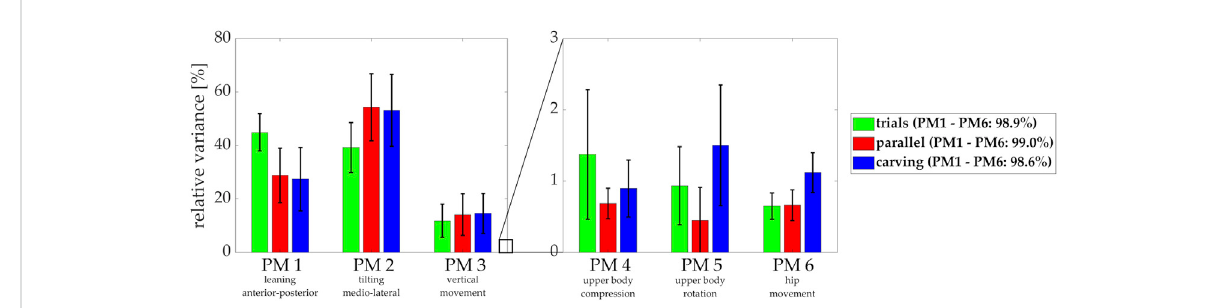
FIGURE 5 Relative variances explained by the fi rst six principal movements (PMs) for the trials with instructed technique variations (green bars) [this is the dataforwhichthePCAwascalculatedinstep1]andrelativevariancesfortheparallel(red)andcarvingturns(blue)analyzedinstep2[thesedatawere projected onto the PC-eigenvectors obtained in the analysis of step